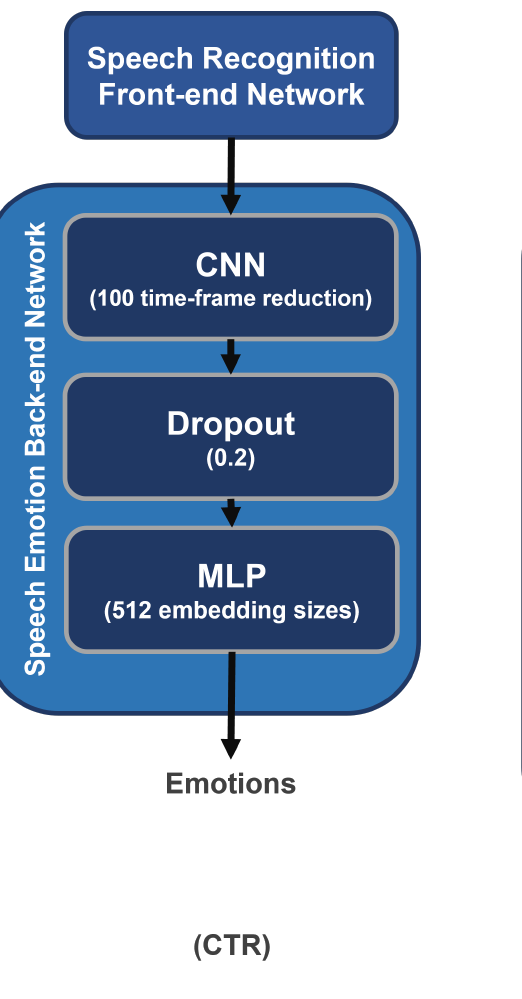
Figure 2. Speech emotion back-end network process. ( Left ) convolution time reduction (CTR). ( Right ) linear mean encoding transformation